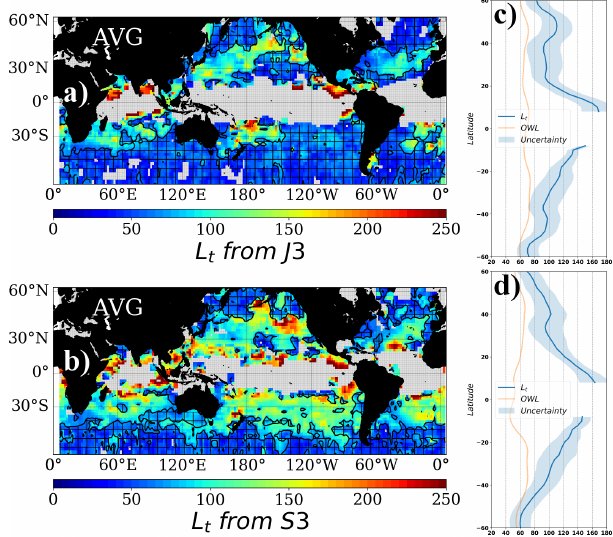
Figure 6. Intercept scale (in km) between the large- and small-scale spectral slopes for J3 (a) and S3 (b) . Shaded and hatched areas cor- respond to regions where the intercept scale is smaller than the local observable wavelength (signal-to-noise ratio equals 1). Blank areas in (a) and (b) correspond to the regions where the observed PSD is accounted for using a single-slope approach. (c, d) Zonal aver- ages of (a) and (b) . The uncertainty envelope is also included in the zonal average. Orange lines in panels (c) and (d) correspond to the zonal average of the observable wavelength for J3 and S3A, re- spectively (Figs. 1d and 2d). Note that the average intercept scale is always higher than the average OWL. We also verified that the first baroclinic Rossby radius of deformation is larger than the com- puted intercept values. White contours represent the topography at 3000m